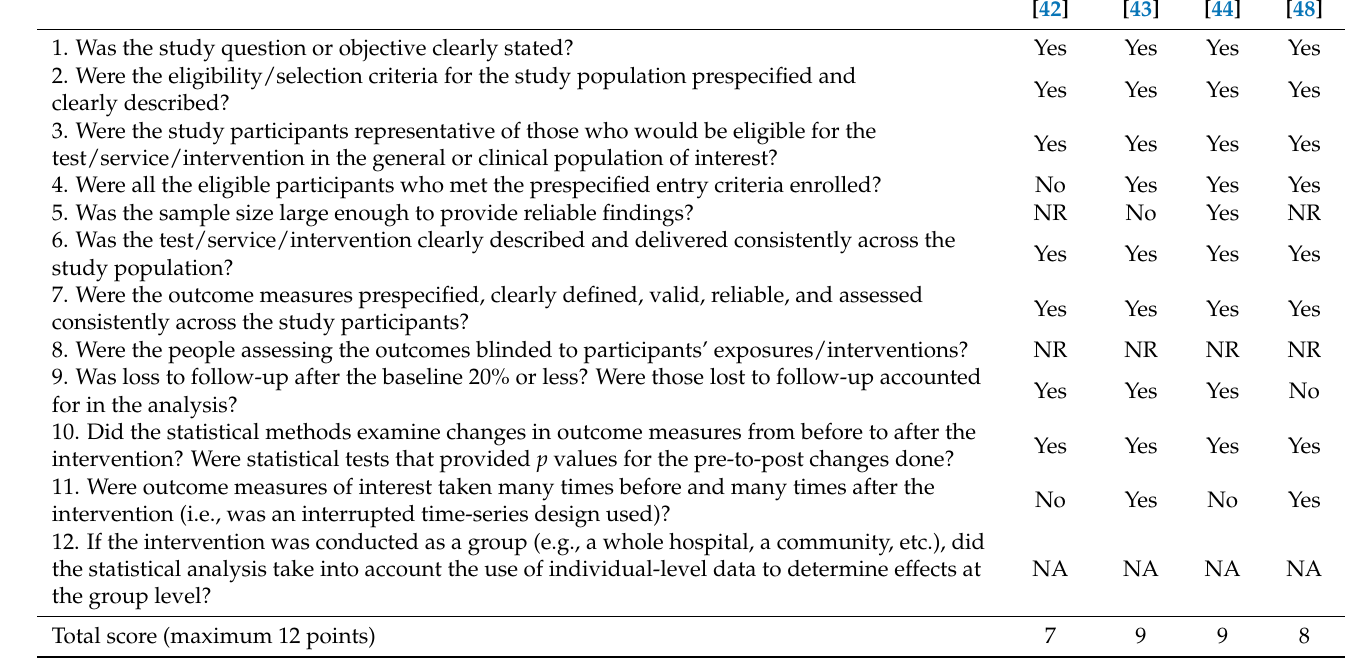
Table A2. Quality assessment of Before–After Studies (NHLBI).